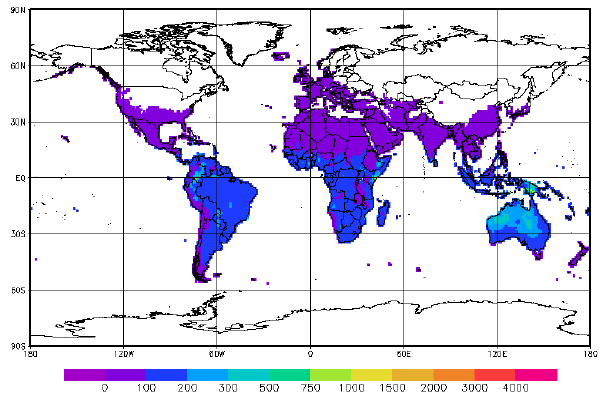
Figure 8. The SPEI with 3-month aggregation interval for Jan- uary 2014. The color scale is the same as in Fig. 3.